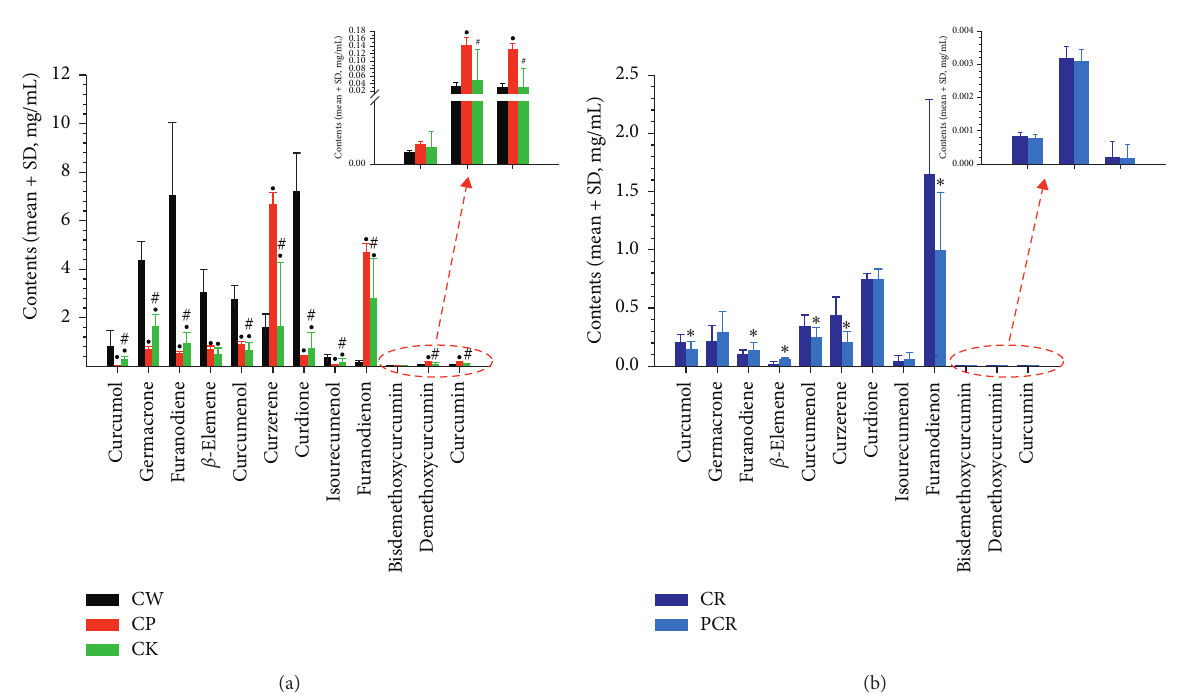
Figure 3: Contents of twelve chemical ingredients in different species (a) and different prepared slices (b) of Zedoray Rhizome samples. • Compared with CW, p < 0 . 05; # compared with CP, p < 0 . 05; ∗ compared with CR, p < 0 .